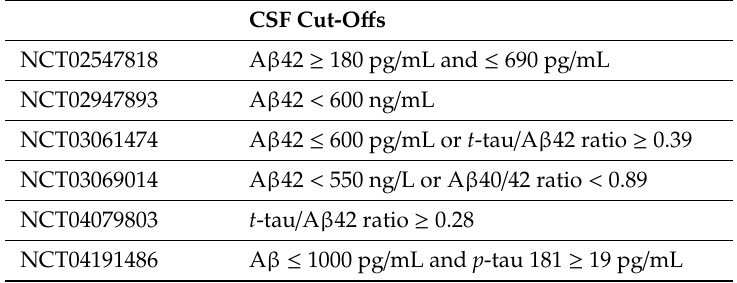
Table 2. CSF cut-offs adopted in the six protocols with available information.